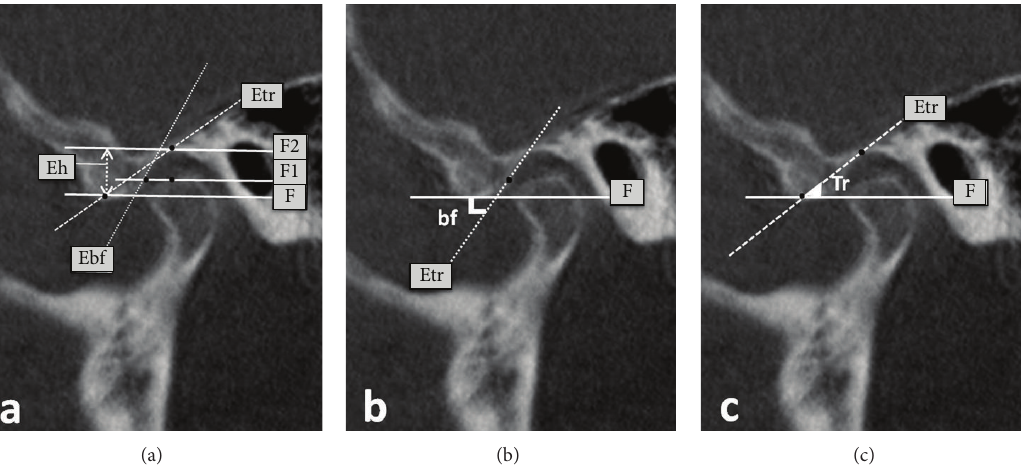
Figure 1: (a) The points and planes used in this study, (b) the best-fit line method, and (c) the top-roof line method. F: Frankfort horizontal, F1: the parallel line to the F passing through the highest point of the condylar process, F2: the parallel line to the F passing through the highest point of the fossa, Ebf plane: the best-fit plane of the articular eminence inclination connecting the point, at which the F1 line cut the eminence posterior surface, Etr plane: the plane passing through the highest point of the condylar process and the highest point of the condylar process, and Eh: Eminence height.